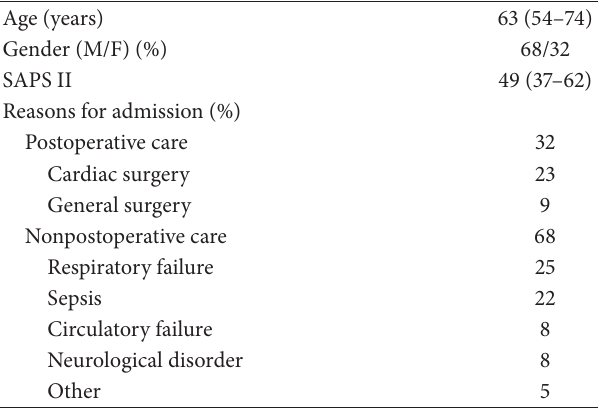
Table 1: Patient background characteristics 𝑛 = 73